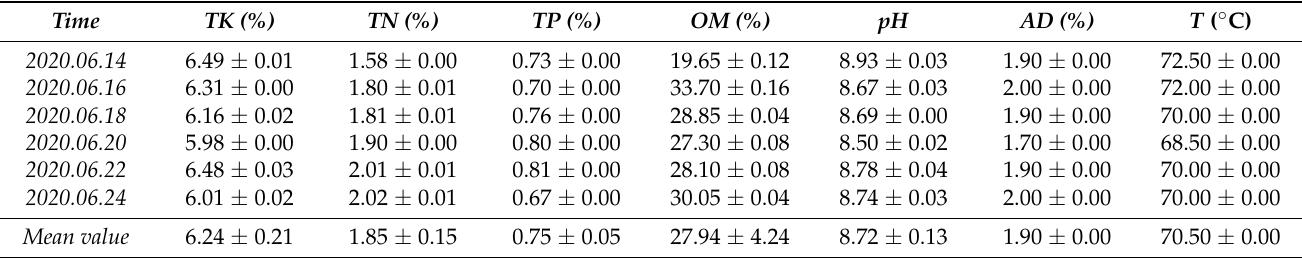
Table 1. Physicochemical parameters in composting piles.